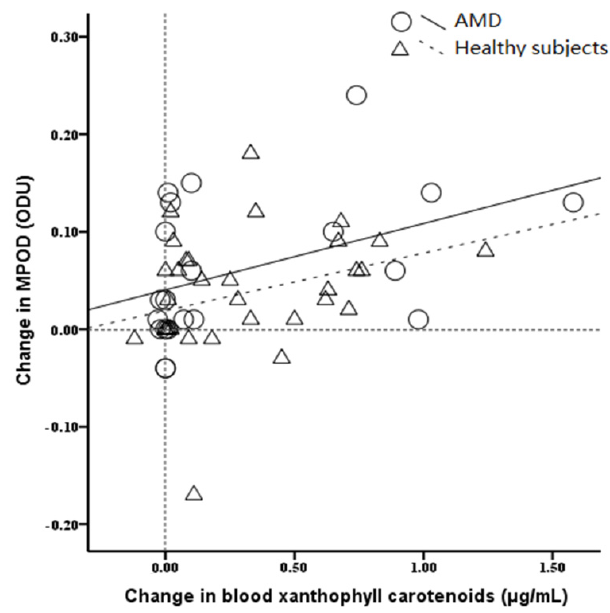
Figure 3. Scatterplot showing the relationship between blood xanthophyll carotenoids concentration and the change in MPOD during supplementation. MPOD, macular pigment optical density; ODU, optical density unit.